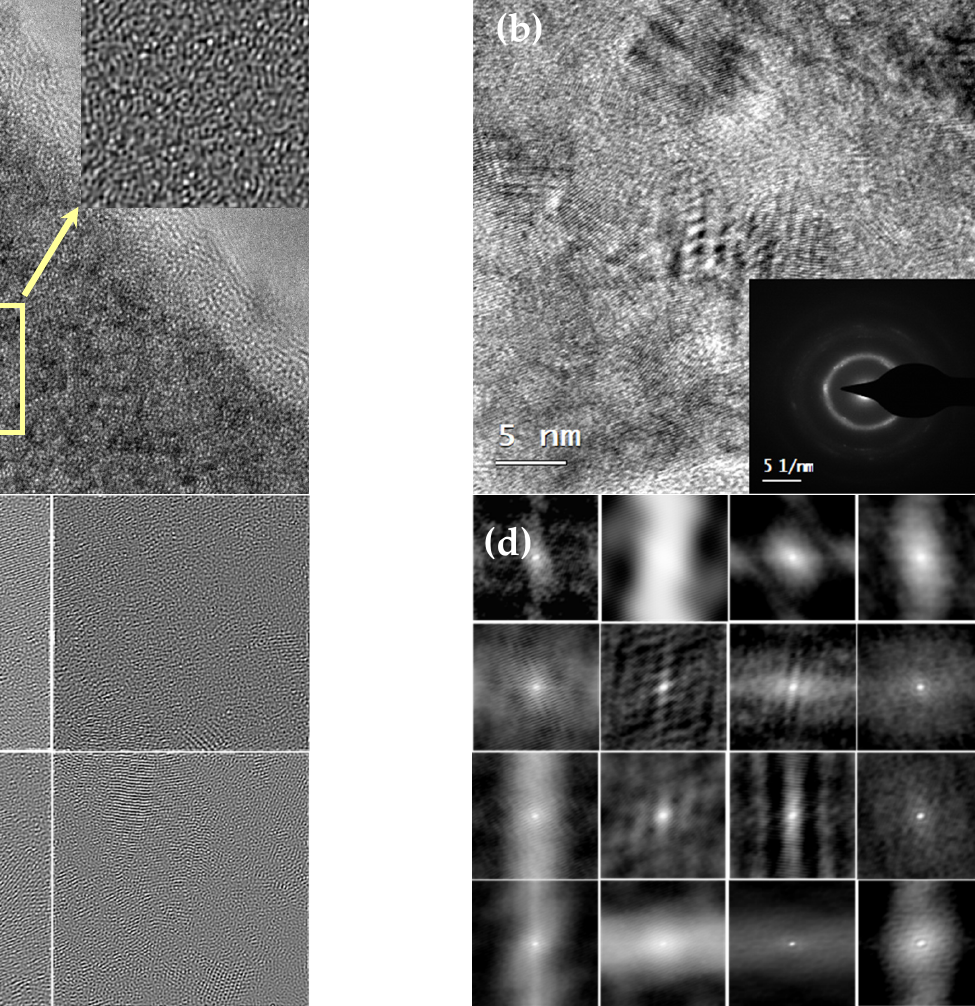
Figure 6. HRTEM images of the Co ‐ Fe ‐ based microwires: ( a ) as ‐ cast state; ( b ) AJA ‐ treated by 250 mA; ( c ) ACF ‐ ed patterns of ( b ); ( d ) (FFT–IFFT) ‐ ed pattern of ( b ). The square plot indicated by the arrow in Figure 6a is the autocorrelation function plot of the selected area.